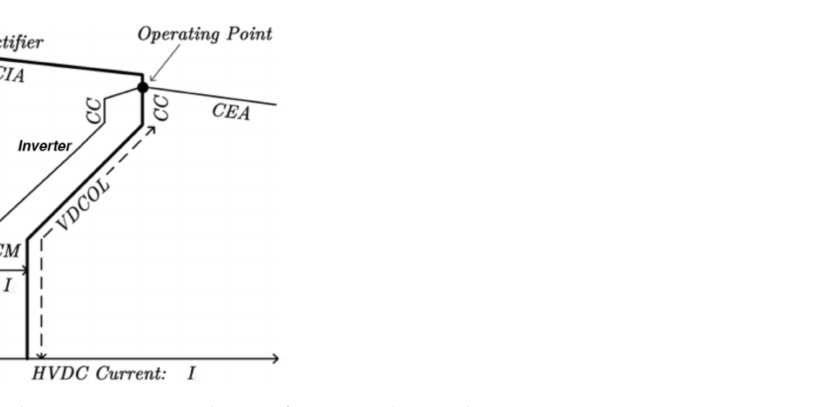
Figure 3. Characteristic control curve for HVDC line with LCC converters.